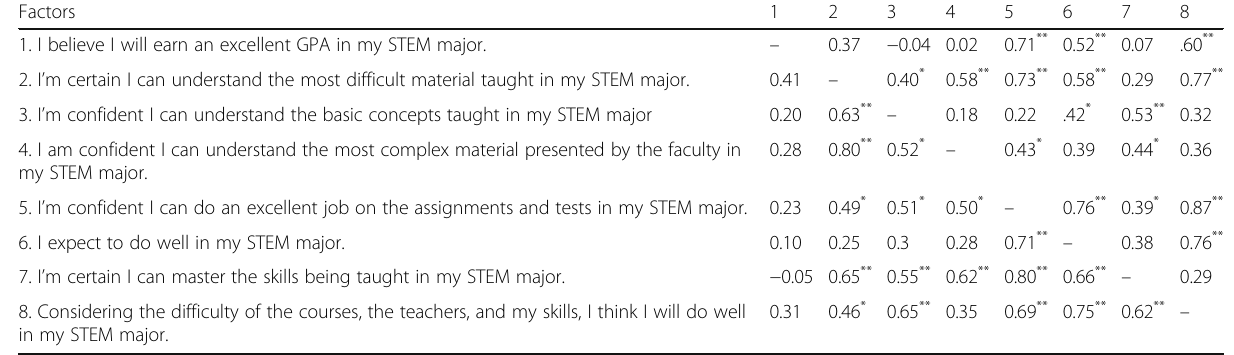
Table 14 Correlations for MSLQ subsection on self-efficacy for learning and performance motivation